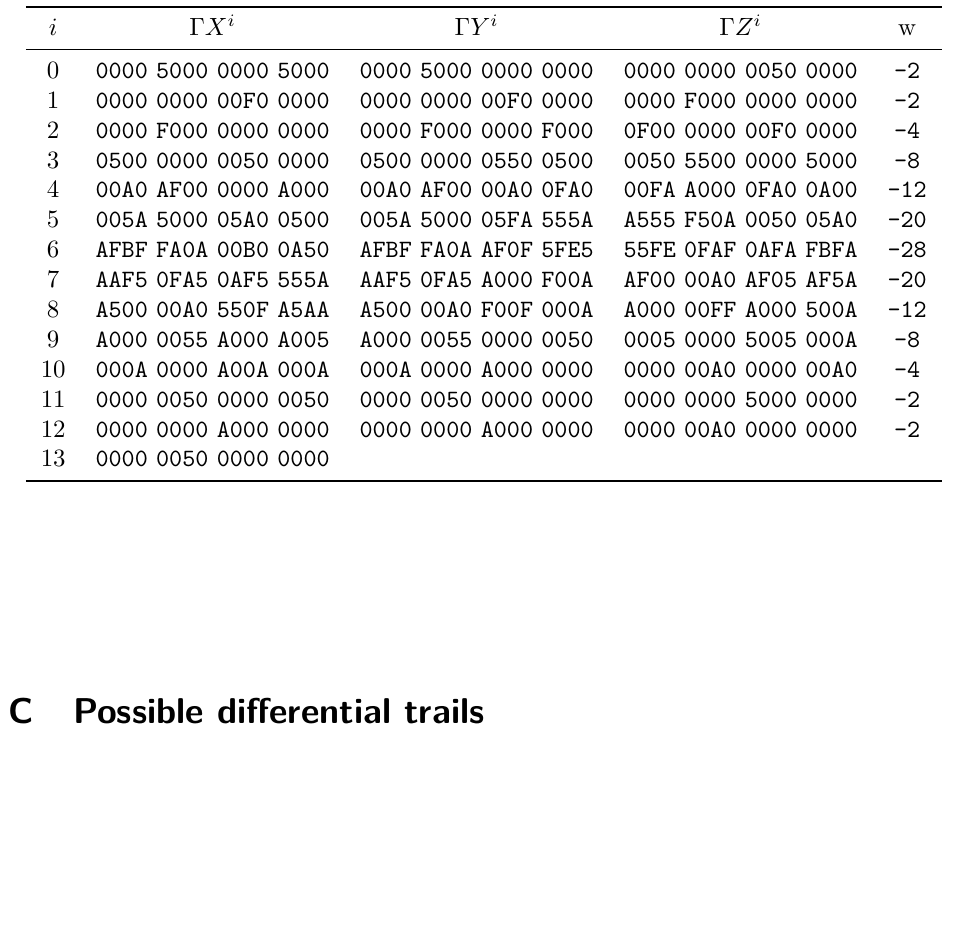
Table 12: A possible differential trail with weight 124, corresponding to the